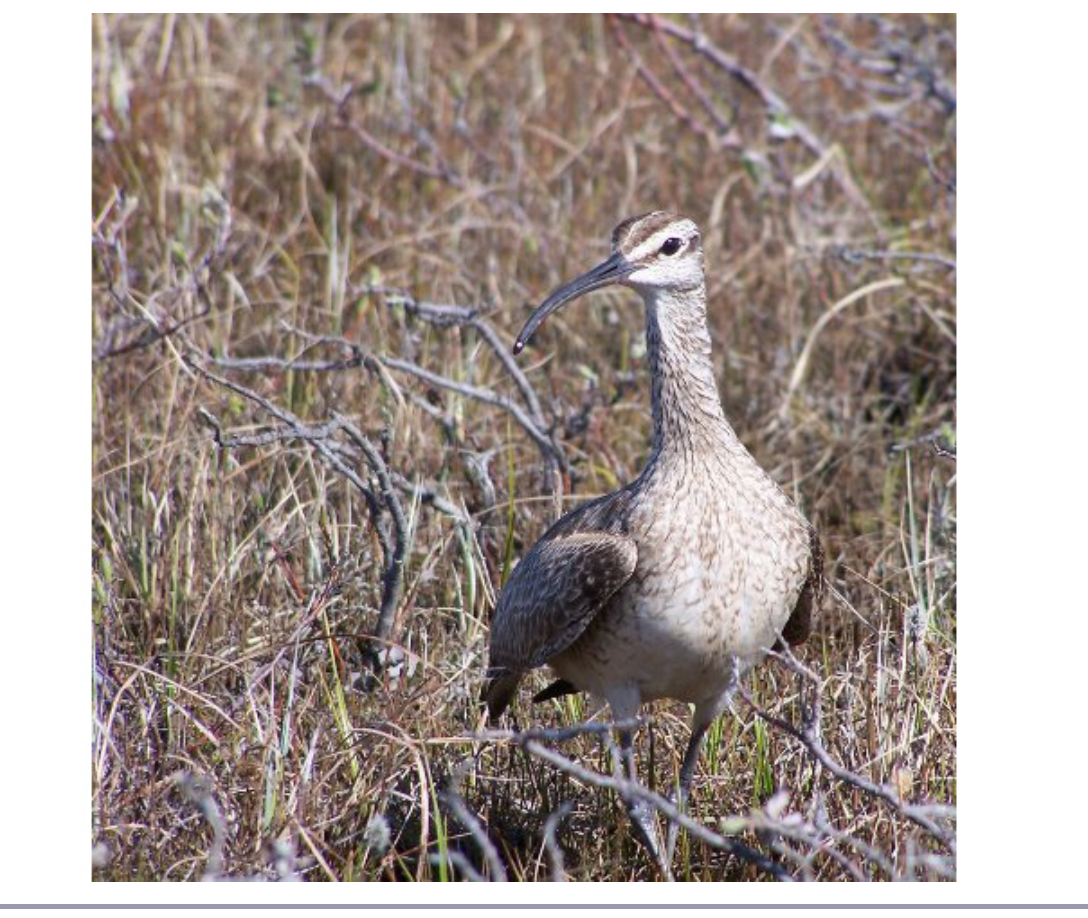
Fig. 4. A breeding adult Whimbrel ( Numenius phaeopus ) in the outer Mackenzie Delta, Northwest Territories. Photo by Krista Sittler